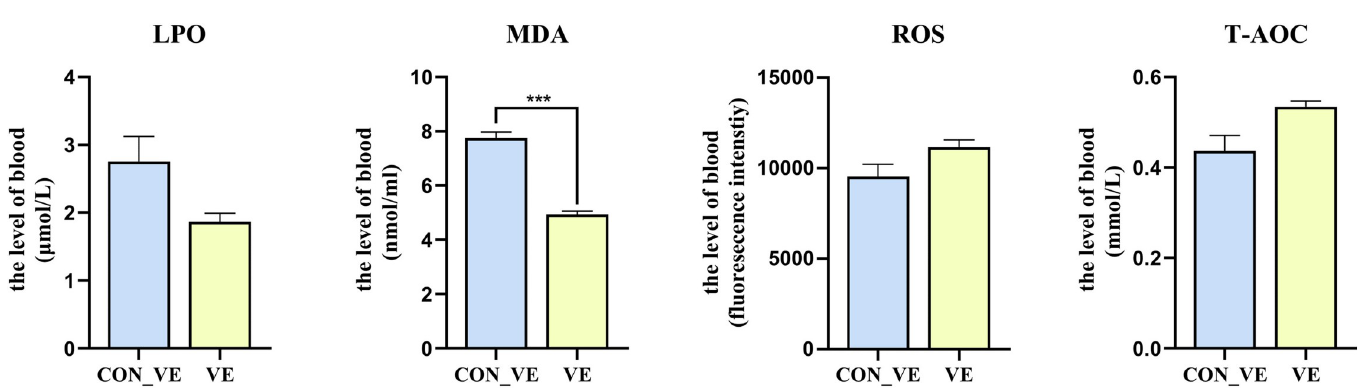
Fig 2. The blood serum level of LPO, MDA, ROS and T-AOC before and after VE injection after transportation in